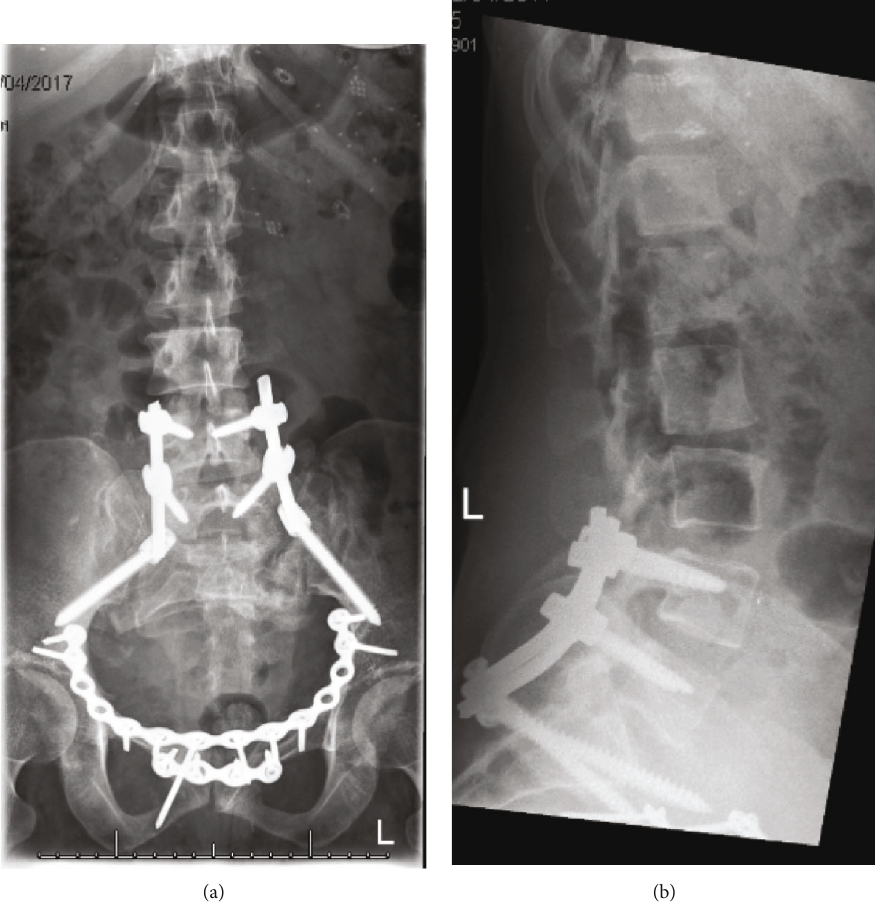
Figure 4: Postoperative pelvic X-rays and lumbosacral X-rays showing bone union in the pelvis and su ffi cient bone fusion in L4-S1 vertebrae in the antroposterior (a) and lateral views (b), respectively.